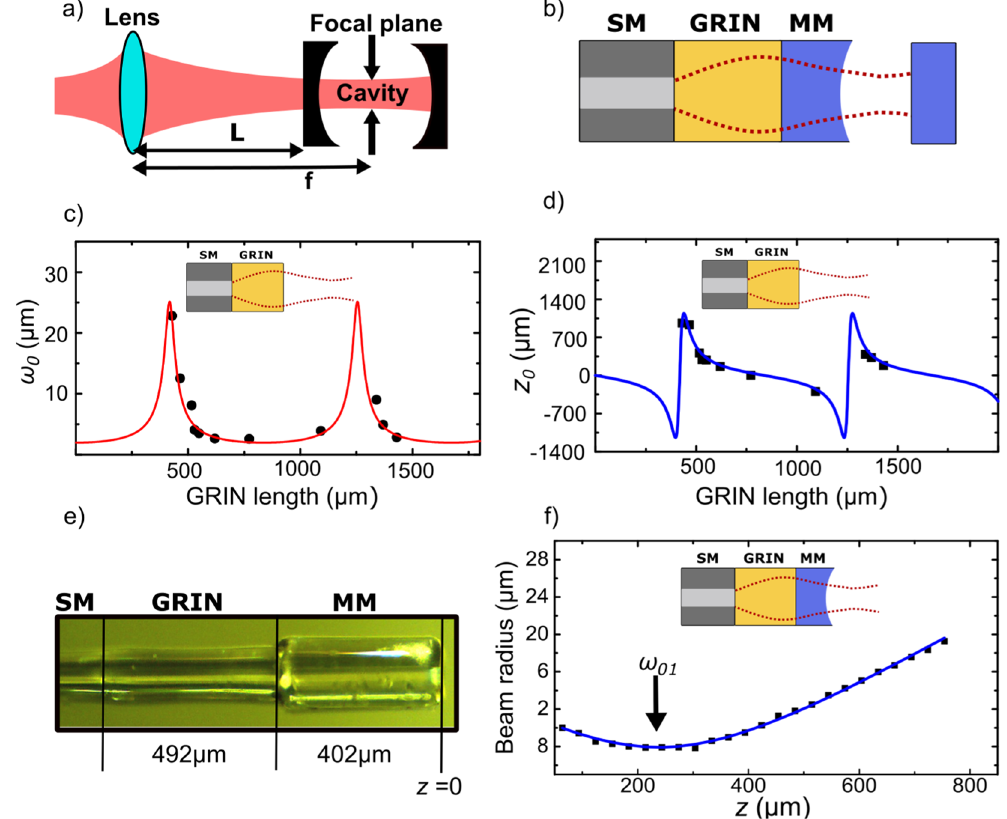
Figure 1. ( a ) Mode matching between an optical cavity and a laser beam in free space. ( b ) Design of the mode matching fiber assembly. ( c ) and ( d ) Waist size ( ω 0 ) and waist position ( z 0 ) with respect to end facet of GRIN fiber as a function of GRIN fiber length for a simple SM-GRIN unit. Solid lines are calculated results using the ray matrix transformation method with a fitted value of gradient constant ( g ) of 3.77 mm − 1 . ( e ) Actual mode matching fiber assembly (FA) with the GRIN and MM fibers of length 492 μ m and 402 μ m respectively. The lengths of the respective fibers determine the mode waist ( ω 01 ) and waist position ( z 01 ) of mode at the output of the FA (SM-GRIN-MM). ( f ) Mode radius of the output from the FA, where z = 0 is the laser ablated end facet of the MM fiber. Waist size ( ω 01 ) of 8.1 μ m at z 01 = 230 μ m is obtained by fitting the data with the propagation of a Gaussian